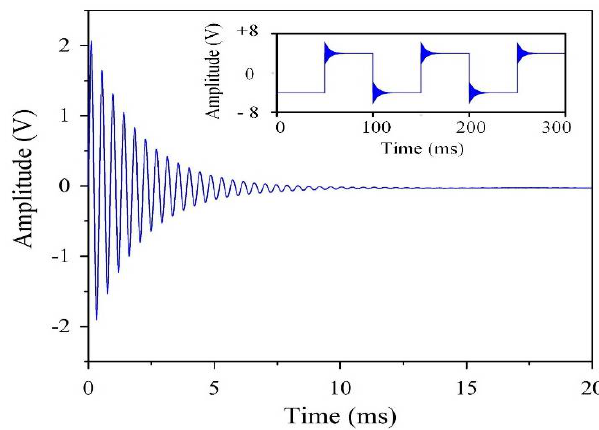
Figure 3. Ringing signal recorded by the LC resonance magnetic sensor. The inset shows the ringing appearing after each rising and falling edge of the square wave.